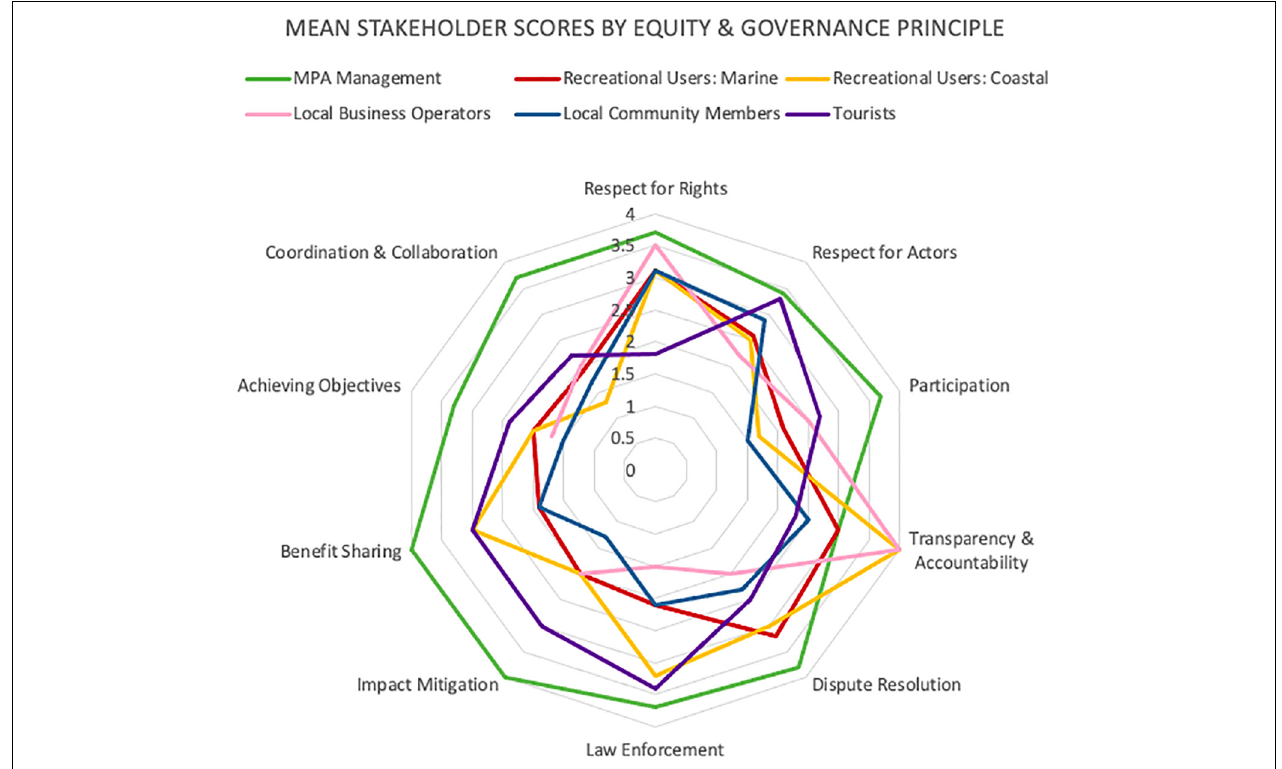
FIGURE 4 | Mean stakeholder scores by equity and governance principle for Carlingford